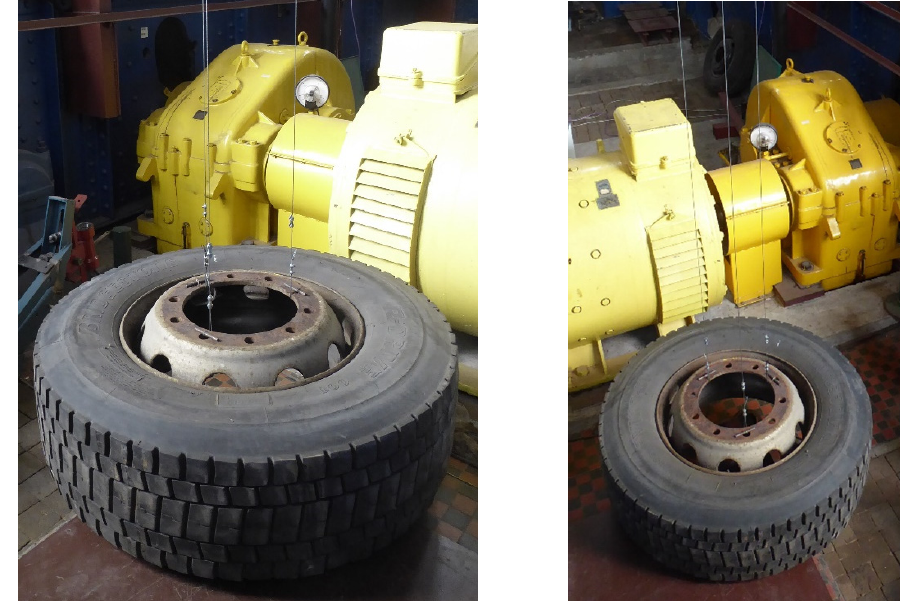
Figure 5. Wheel mounted on the stand for determining the mass moment of inertia.